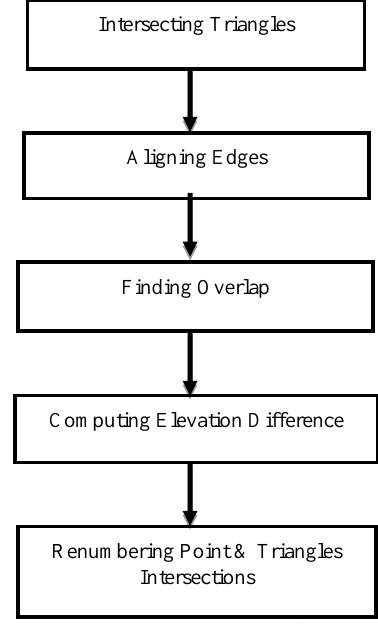
Figure 3. Volume computation